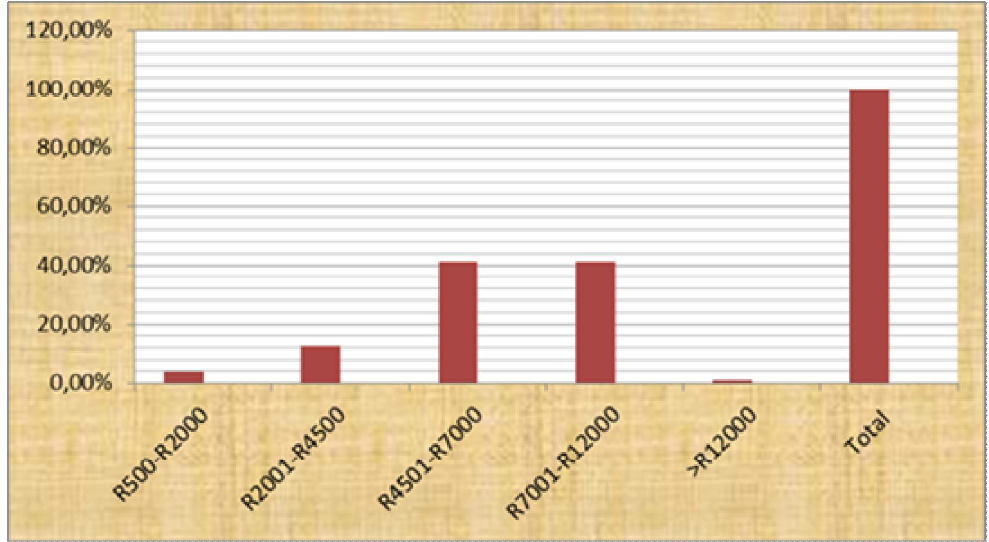
Figure 4: Total monthly household income